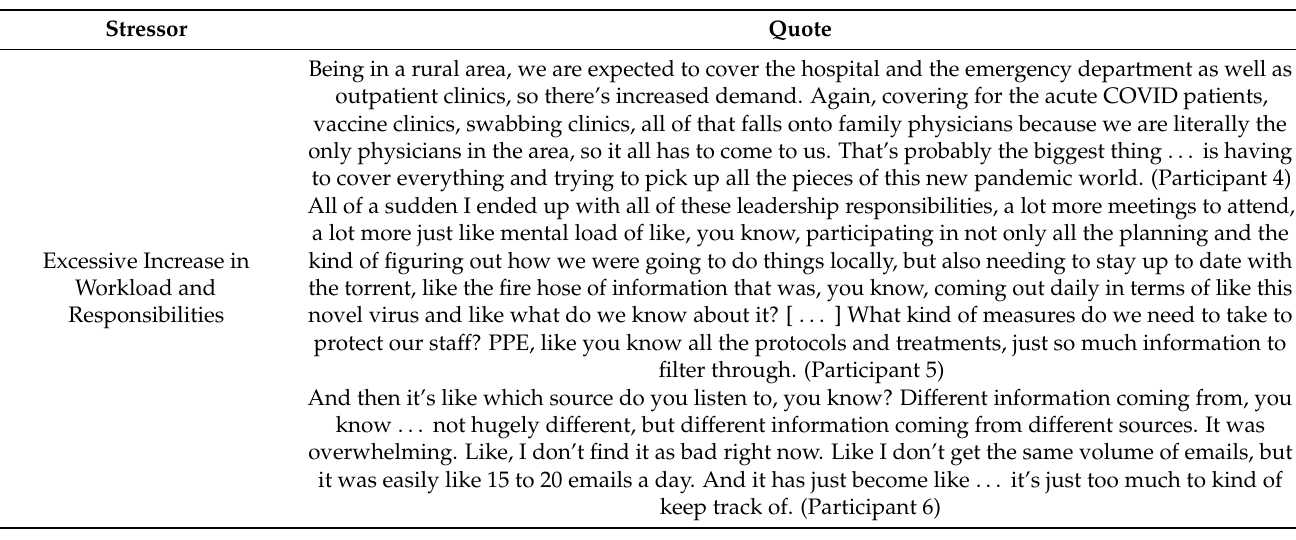
Table A3. Quotes from participants about stressors affecting psychological wellbeing of rural physi-